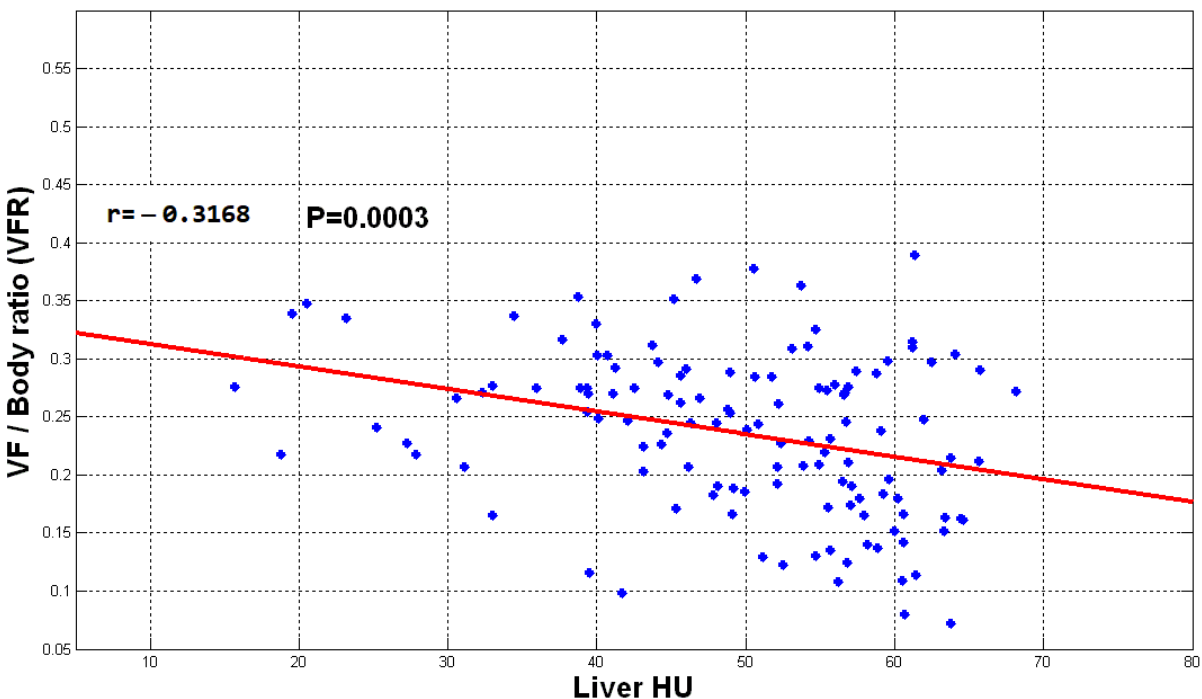
Figure 16. The plot of VFR vs. liver mean HU